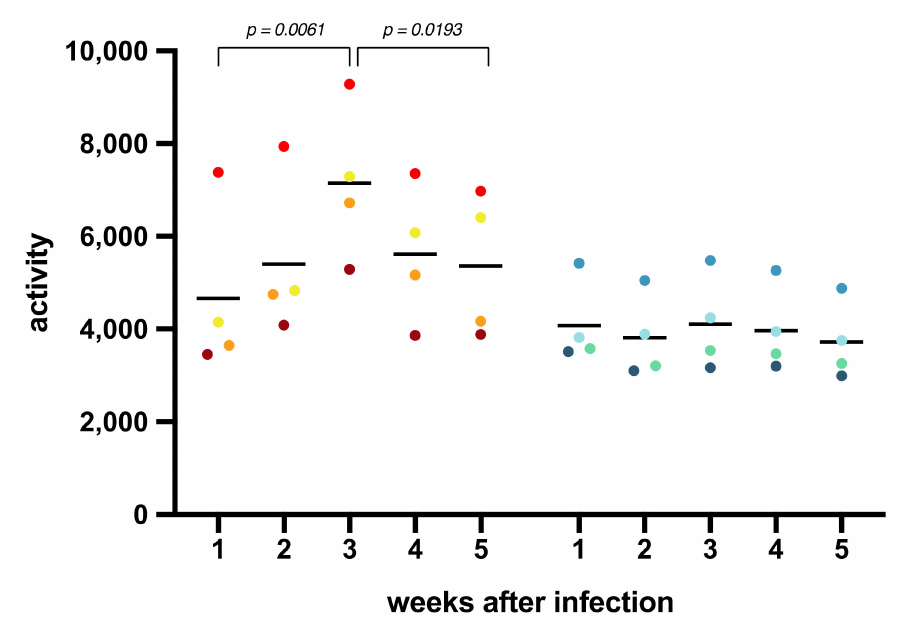
Figure 2. Cumulative activity scores. The activity of the animals was measured by telemetry throughout the study. The cumulative activity scores for rhesus and cynomolgus macaques were calculated as the area under the curve (AUC) per week. Measurements done during biotechnical handlings were omitted from the